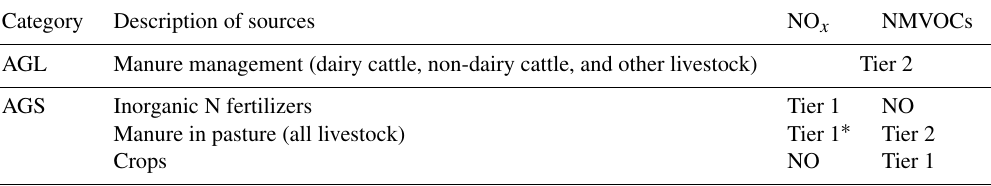
Table 1. Level of detail of the EMEP 2016 methodology applied in estimating NO x and NMVOC emissions from agricultural activities in